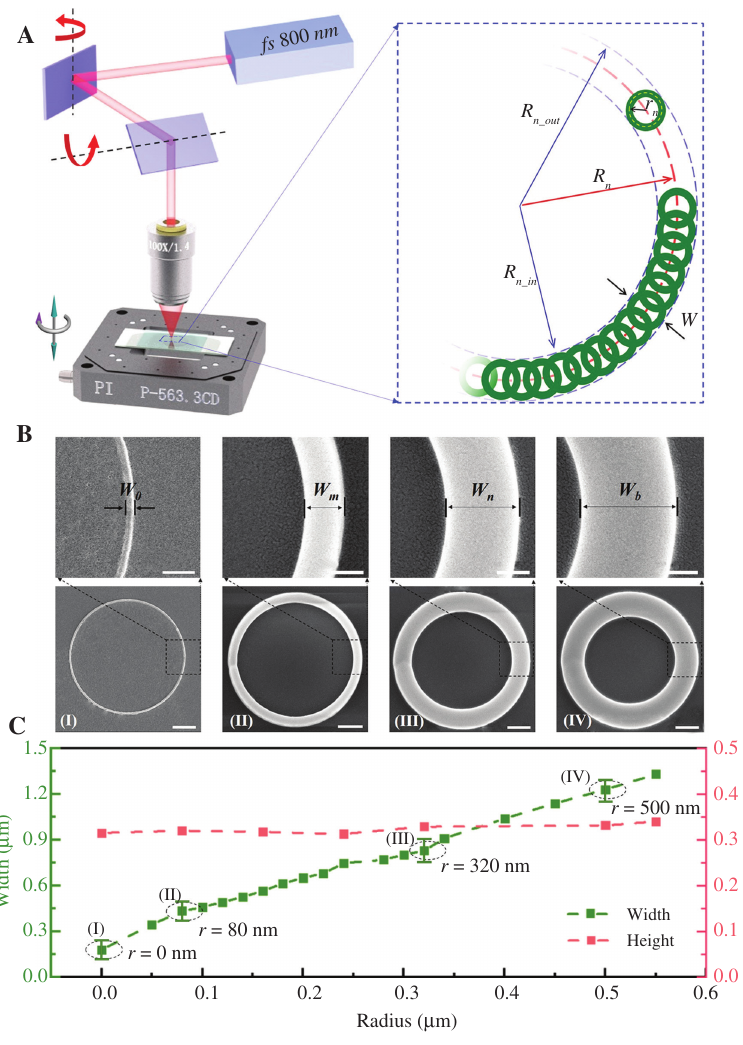
Figure 2: Synergistic dual-mode optical lithography technique. (A) Schematic for the fabrication system. The SCL is patterned by the synergistic movement of the piezo stage and a pair of scanning galvo mirrors. As shown in the inset figure, the structure is sketched out by the trajectory of the piezo stage, and the internal structural feature is controlled by the oscillation of the galvo mirrors. R is the radius of the n belt of the SCL following the trajectory of piezo stage movement, n th and r is the oscillating radius of the galvo mirrors which governs the width of the n belt (W), where the R and the R stand for the inner n th n_in n_out radius and the outer radius of the belt, respectively. (B) Experimentally measured feature sizes of the fabricated belts versus the oscillating radiuses of the galvo mirrors. The widths of the belts can be precisely controlled by the r . Sub-panels of I–IV show the SEM images of n = 0 nm, 80 nm, 320 nm, and 500 nm, corresponding to W = 180 ± 30 nm, W = 435 ± 30 nm, W = 770 ± 50 nm, the belts fabricated with r n 0 m n = 1200 ± 50 nm, respectively. As the power of the fs laser beam and the piezo-stage movement speed are fixed at 30 mW and 40 μ m/s W b for all cases, respectively, the thickness of the belts as fabricated are kept in an invariable value of around 350 nm, as represented by pink cubes shown in (C). Scale bars: 1.2 μ